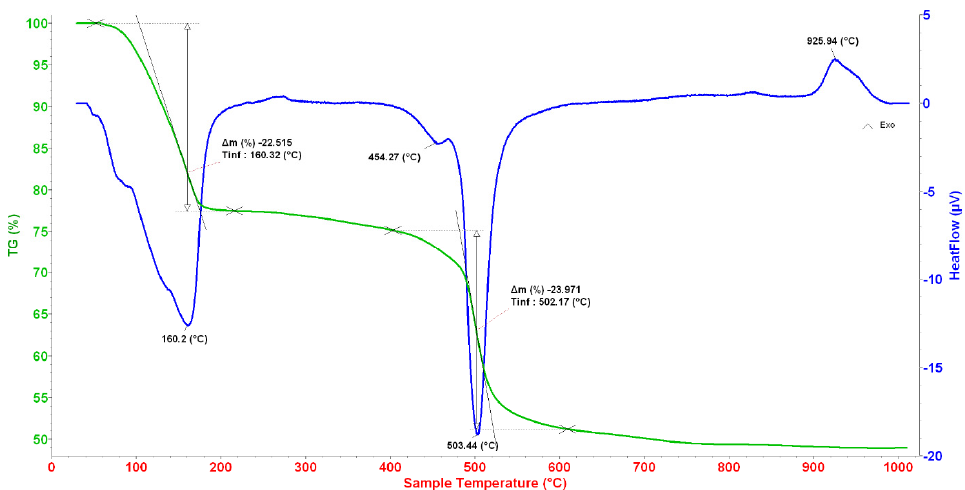
Figure 1. TG-DSC curves of the as-sintered glass Figure 1. TG ‐ DSC curves of the as ‐ sintered glass sample.